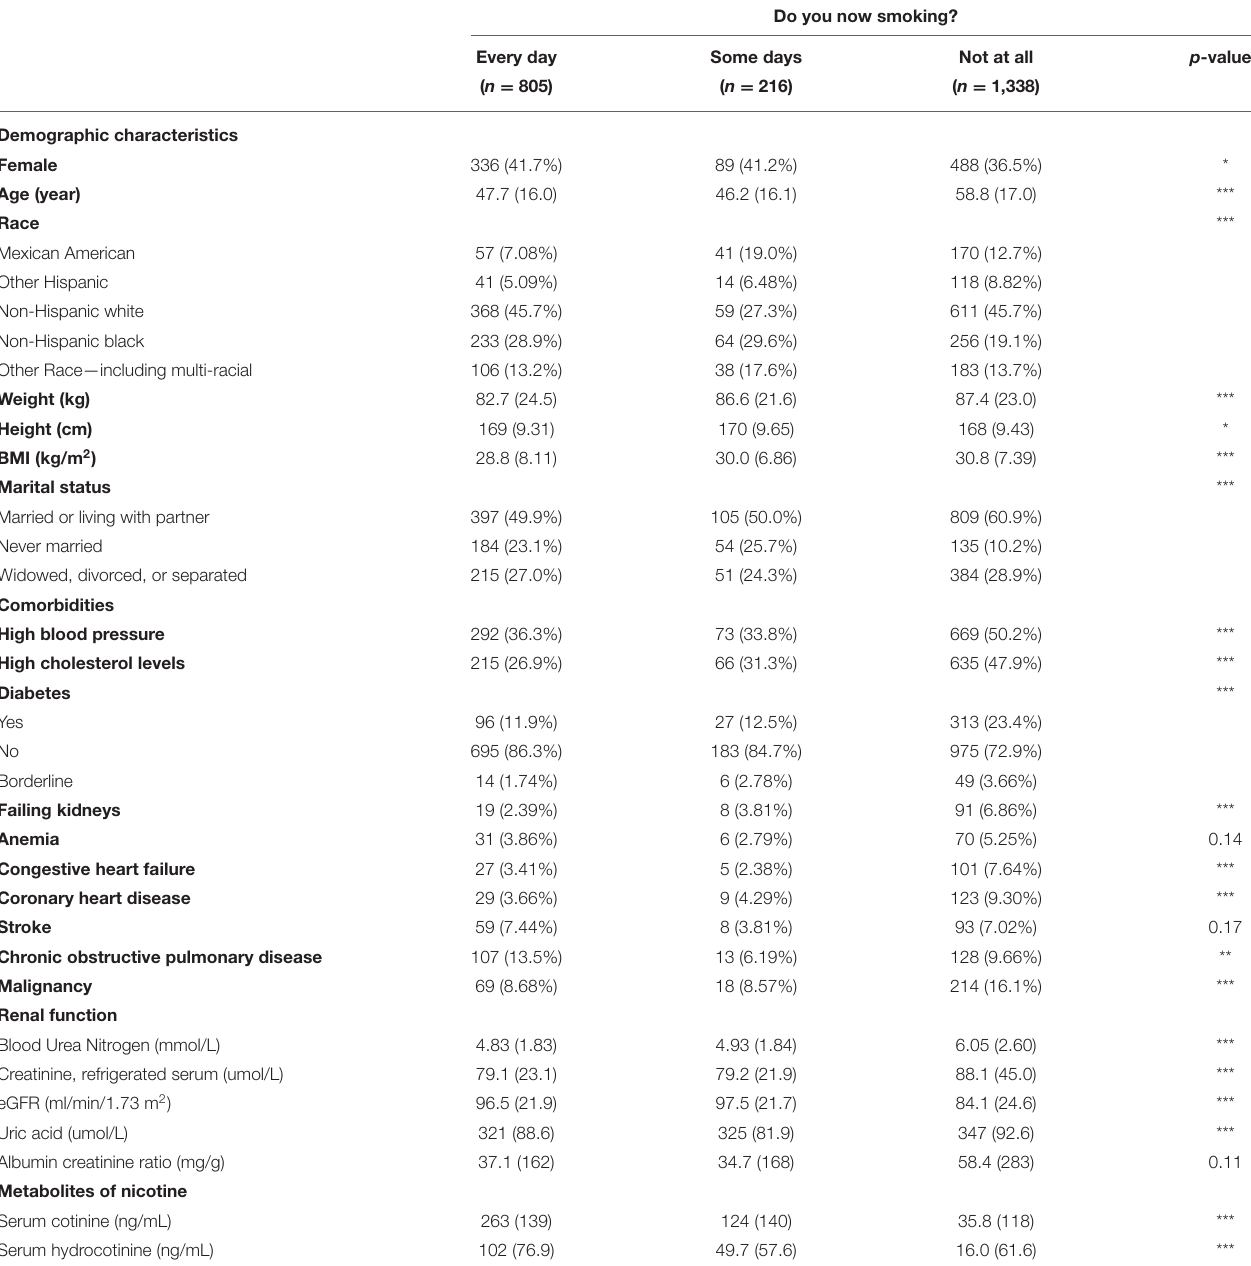
TABLE 3 | Baseline characteristics of study population grouped by smoking.